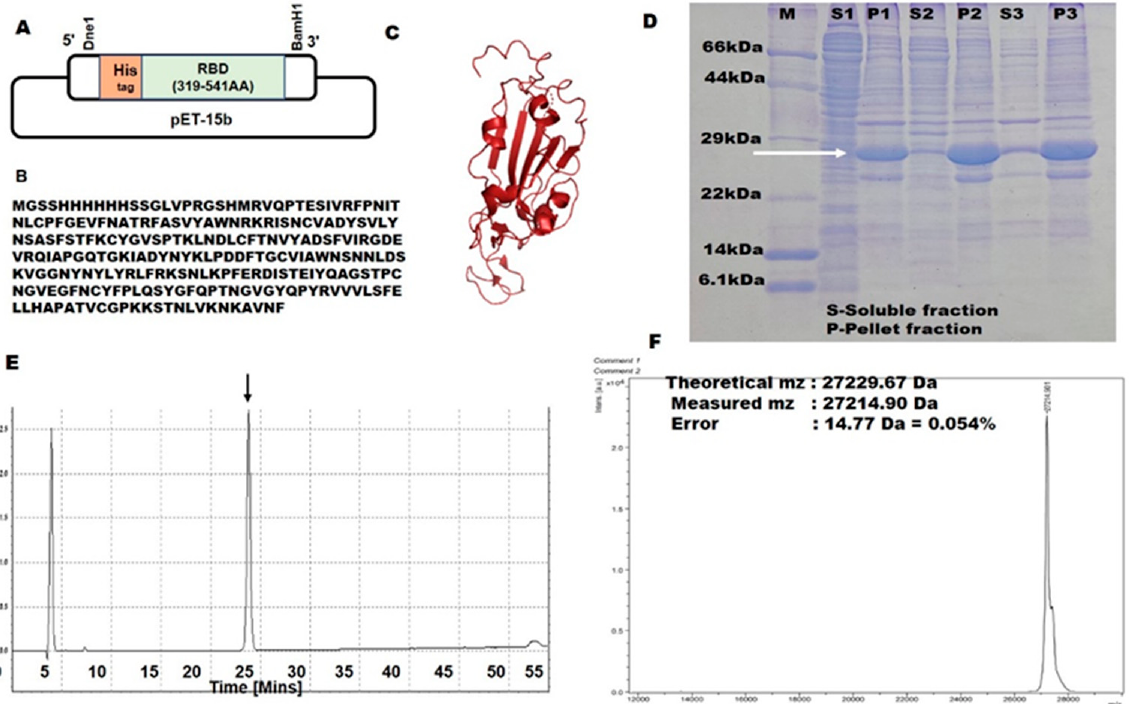
Figure 1. ( A ) Strategy for cloning of SARS-CoV-2 RBD into the pET15b vector with structural demonstration of the SARS-CoV-2-RBD domain. ( B ) amino acid sequence of the target gene cassette. ( C ) Cartoon representation of SARS-CoV-2 RBD generated using Pymol software based on the structure of SARS-CoV-2 RBD (PDB ID-6M0J) [8]. ( D ) Expression analyzed by SDS PAGE. S: a soluble fraction of SARS-CoV-2 RBD, P: pellet fraction of SARS-CoV-2 RBD (1,2,3 represent the rounds of sonication). ( E ) RP-HPLC purification: The elution profile of recombinant SARS-CoV-2 RBD shows the presence of a single peak. ( F ) Molecular weight by MALDI-TOF-MS. Experimental molecular weight (Exp. Mw) was determined by MALDI-TOF Mass-spectroscopy and calculated molecular weight (Cal. Mw) by Protparam (http://web.expasy.org/protparam/ (accessed on 7 November 2022). Relative errors are in percentages (|Exp. Mw—Cal. Mw|/Cal. Mw × 100) .